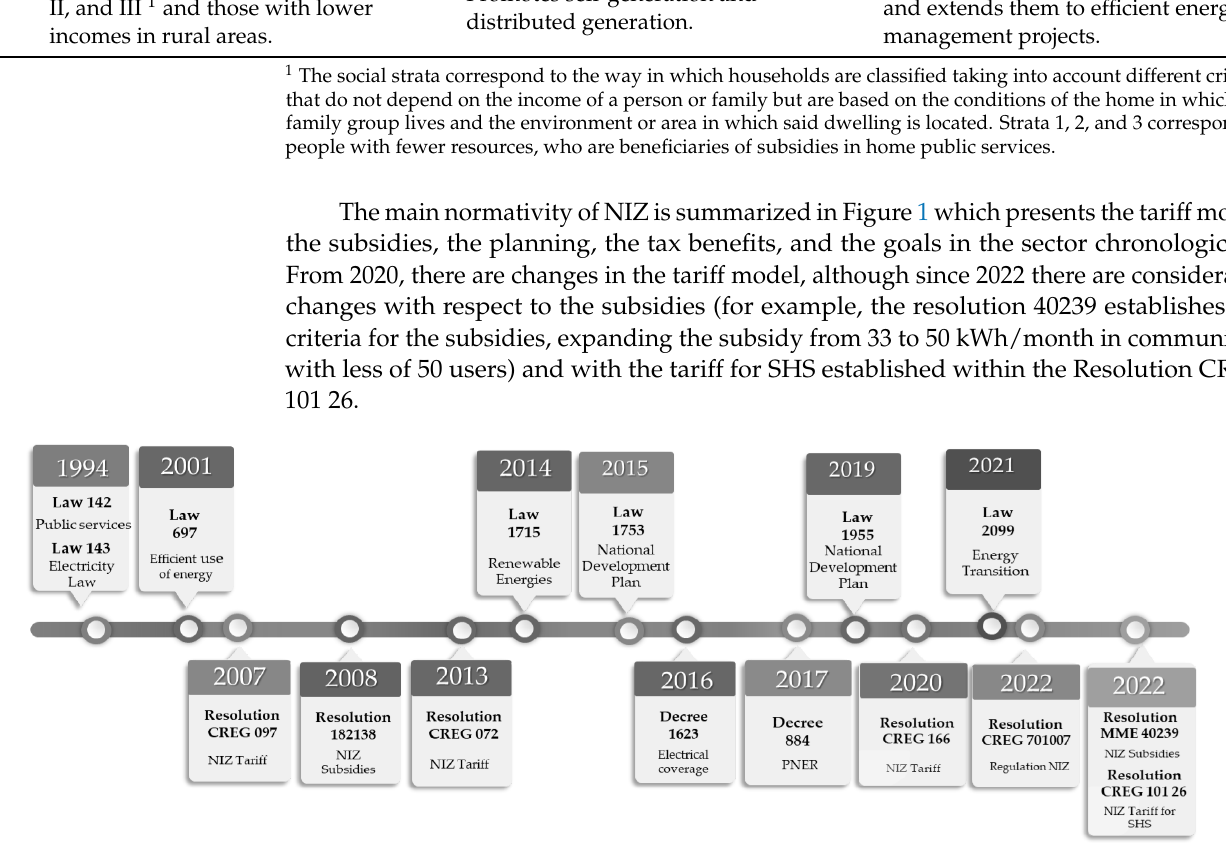
Figure 1. NIZ regulation. Own elaboration.